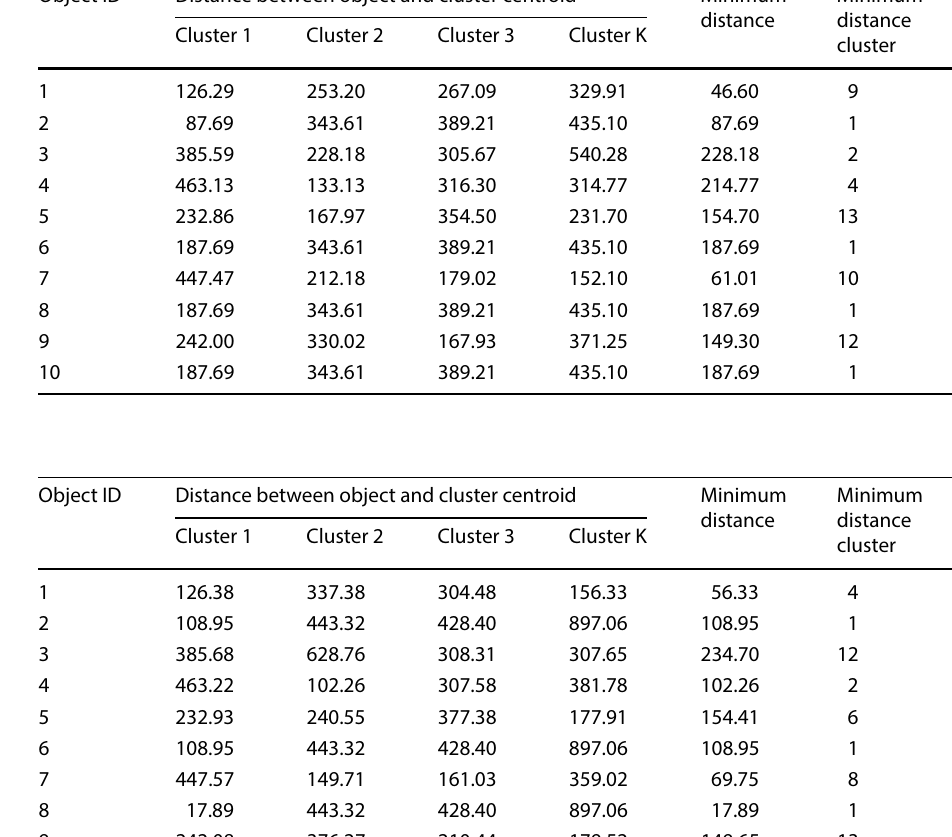
Table 4 Performance of RKMC on UNSW-NB15 dataset